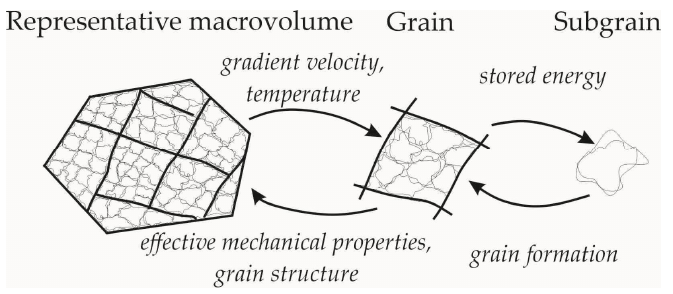
Figure 2. Scale levels and the connection between the structural elements of a multilevel model (thin lines correspond to subgrain boundaries, bold lines show grains boundaries).